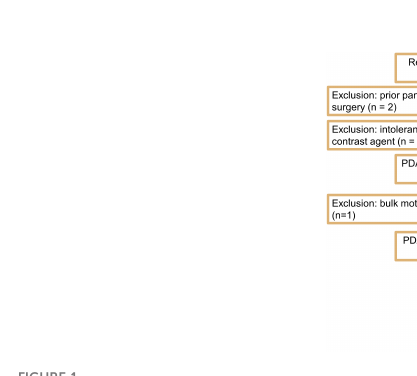
FIGURE 1 Flow chart for subject recruitment and